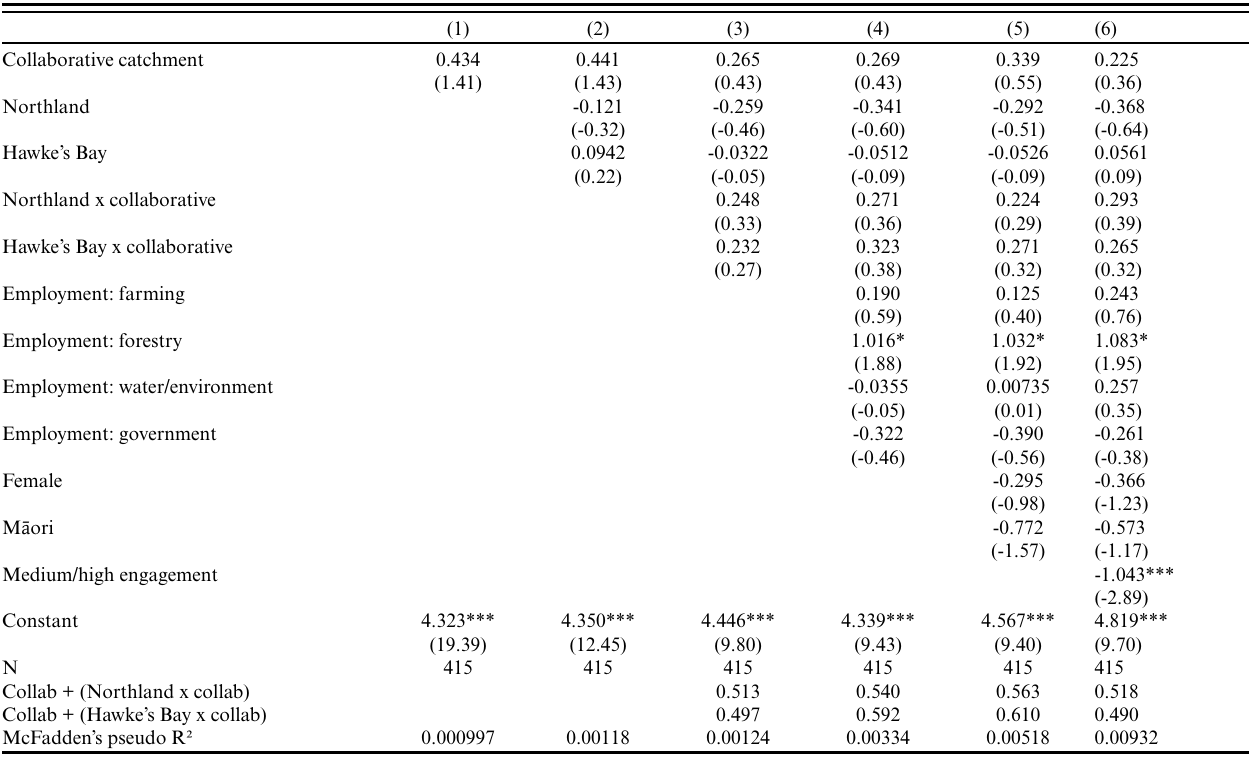
Table 5 . Perceptions of the extent to which interests and concerns with regard to freshwater are taken into account (“Using a scale from 0 to 10, where 0 means not confident at all and 10 means very confident, if you had concerns about how you, your family, or your business was affected by freshwater management, how confident are you that your interests and concerns would be taken into account by the [name of regional